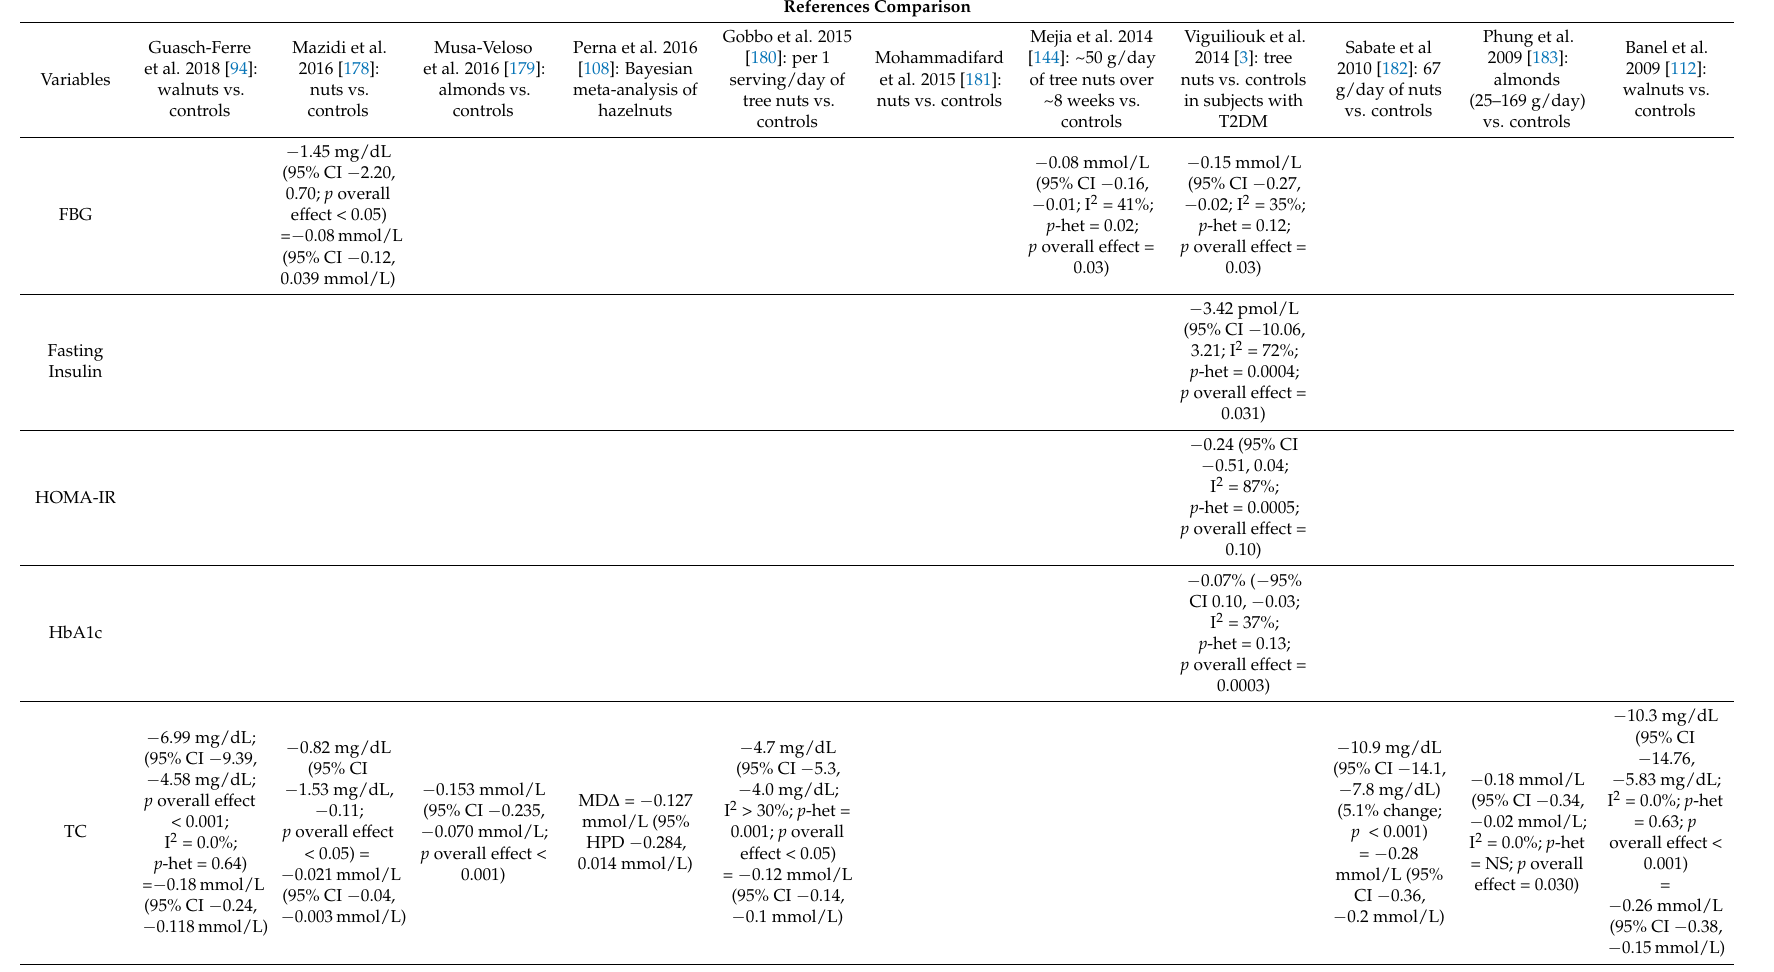
Table 4. Summary of nut consumption and glucose, insulin, lipids and blood pressure in intervention